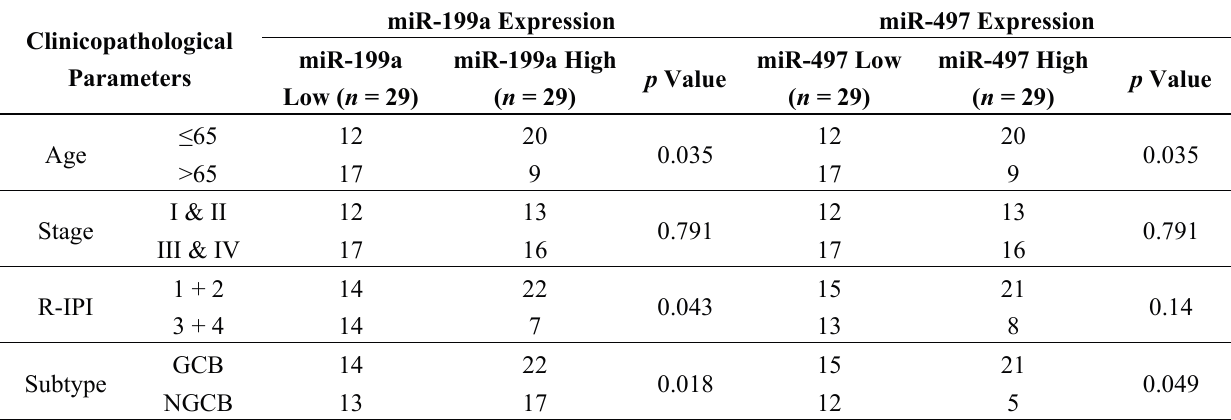
Table 2. Correlations between miR-199a and miR-497 expressions and clinicopathological parameters.